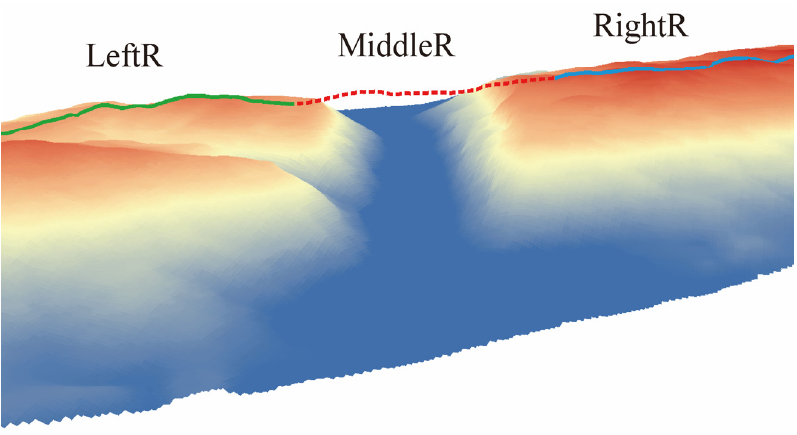
Figure 7. The restored ridgeline MiddleR above C4.